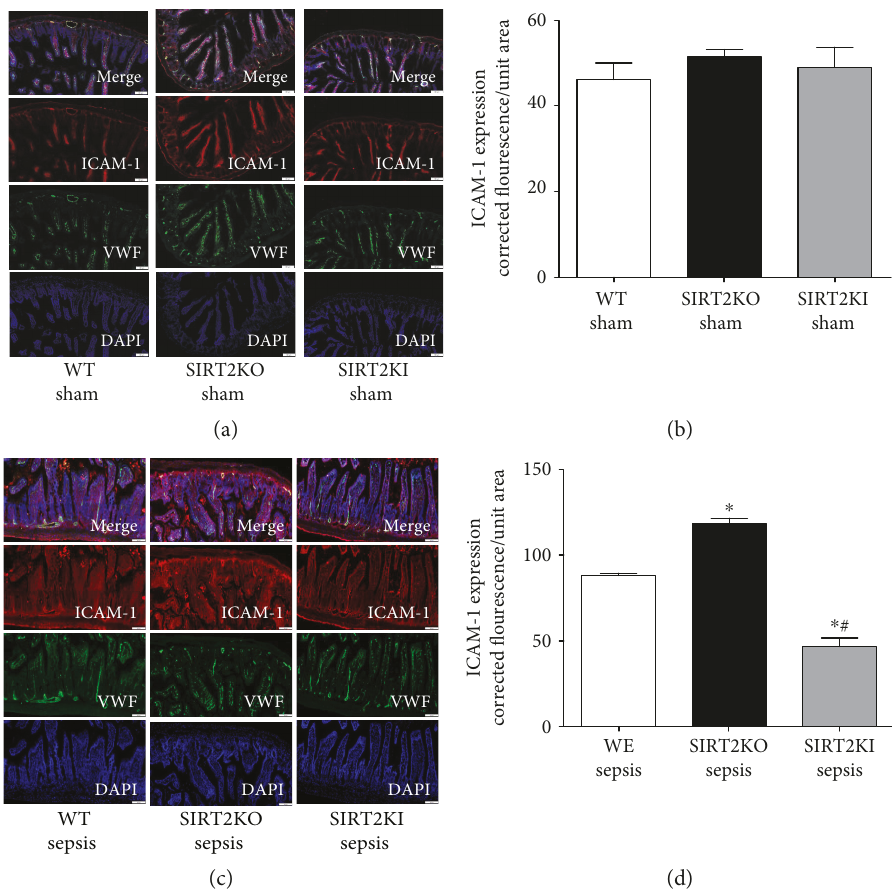
Figure 4: ICAM-1 expression in WT, SIRT2KO, and SIRT2KI mice. We stained small intestinal tissue for ICAM-1 expression. ICAM-1 (Cy3: red), Von Willebrand factor (VWF, FITC: green), and nuclear stain (DAPI: blue). (a) shows representative images of ICAM-1 expression in WT, SIRT2KO, and SIRT2KI mice with sham surgery while (b) shows fl uorescence quanti fi cation of immunohistochemistry of three di ff erent mice in each group. There was no signi fi cant di ff erence in ICAM-1 expression of WT, SIRT2KO, and SIRT2KI mice with sham surgery from each other. As shown in (c) (representative images) and (d) ( fl uorescence quanti fi cation from immunohistochemistry; n = 3 in each group), the ICAM-1 expression increased in SIRT2KO sepsis mice versus that in WT sepsis mice while it was decreased in SIRT2KI sepsis mice versus that in WT and SIRT2KO sepsis mice. ∗ p < 0 05 versus that in WT sepsis group; # p < 0 05 versus that in SIRT2KO sepsis group; using Tukey ’ s post hoc analysis; error bars: